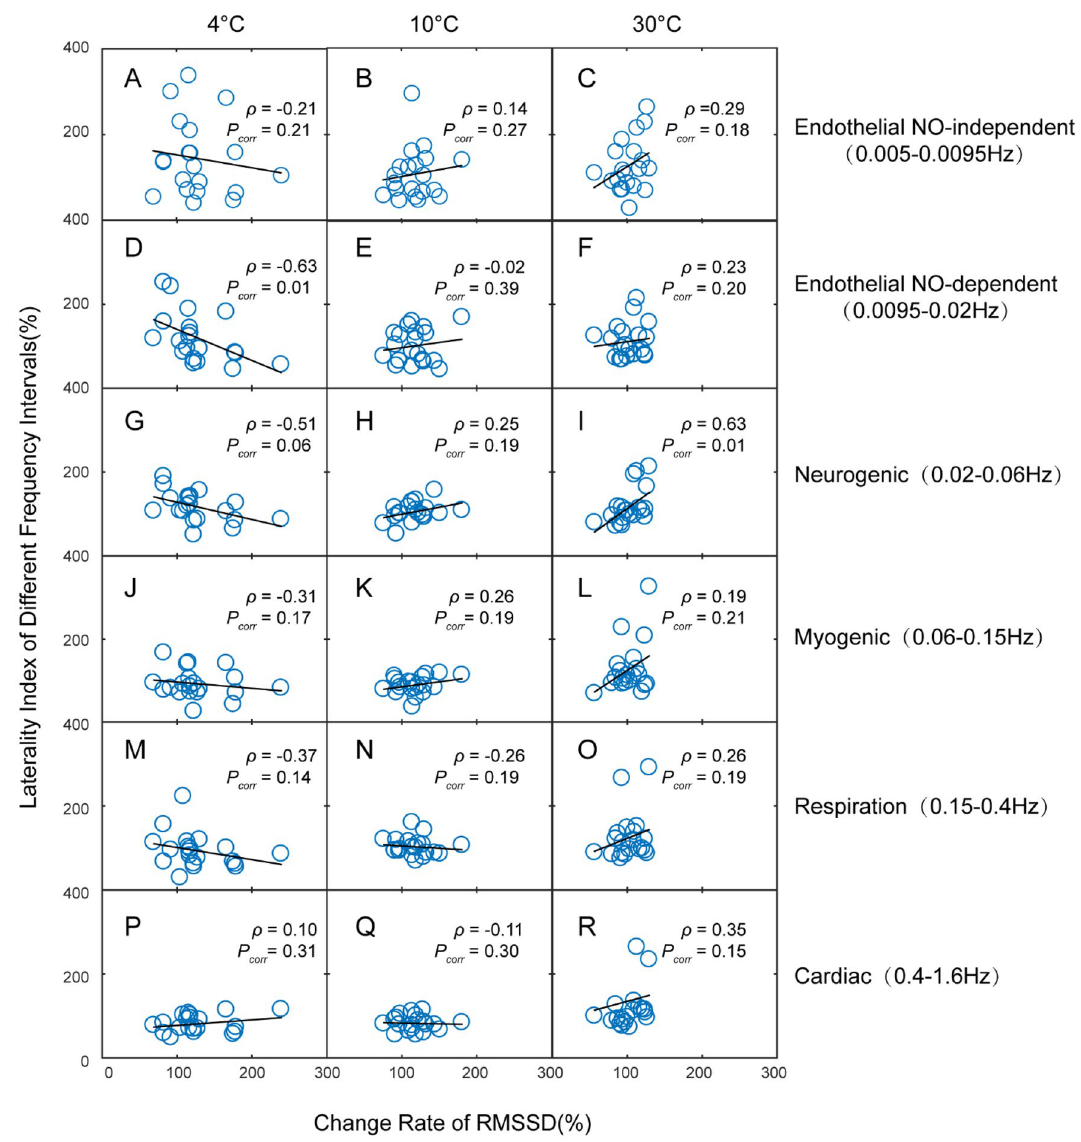
Figure 6. Relationship between laterality index of different frequency intervals and change rate of RMSSD. ( A )–( C ) Endothelial NO-independent; ( D )–( F ) Endothelial NO-dependent; ( G )–( I ) Neurogenic component; ( J )–( L ) Myogenic component; ( M )–( O ) Respiration component; ( P )–( R ) Cardiac component. ρ, Spearman’s correlation coefficient; P corr , corrected P value. RMSSD, root mean square of successive